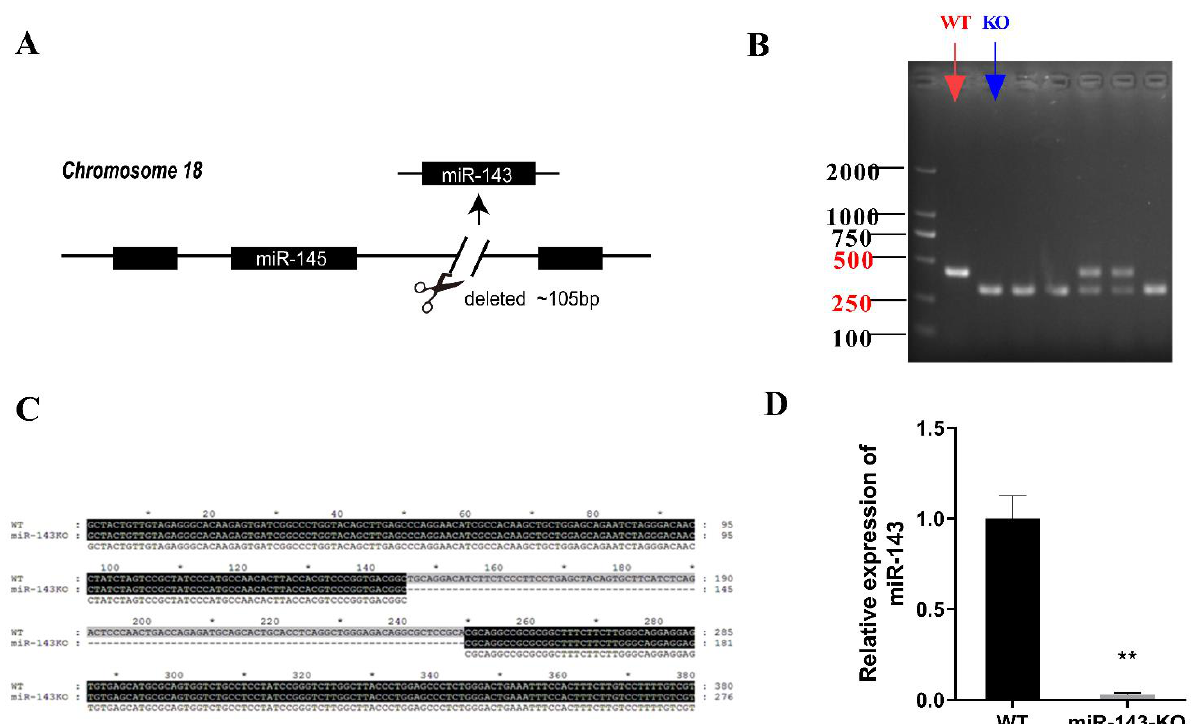
Figure 1. Identification of transgenic mice . ( A ) The schematic diagram of transgenic mice . ( B ) The electrophoretic bands of miR-143 KO mice and WT mice after gDNA PCR. ( C ) Gene sequence alignment of miR-143 KO mice and WT mice . ( D ) The relative expression levels of miR-143 in the liver of WT and miR-143 KO mice . ( * p < 0.05, ** p < 0.01, n = 8).